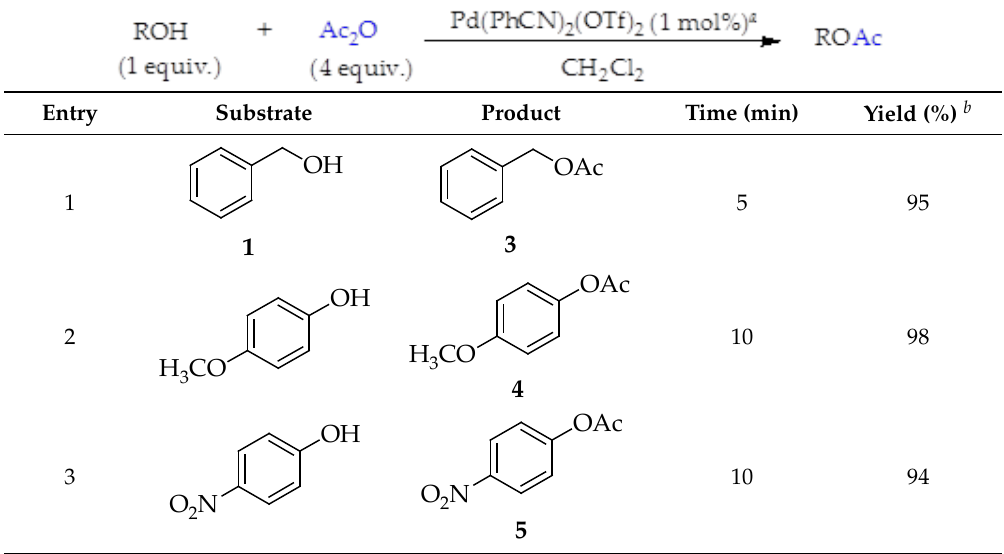
Table 2. Comparison of some acetylation methods with benzyl alcohol as substrate.